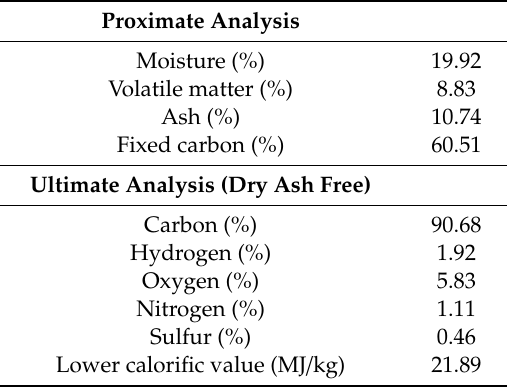
Table 2. Analysis of powder coke.